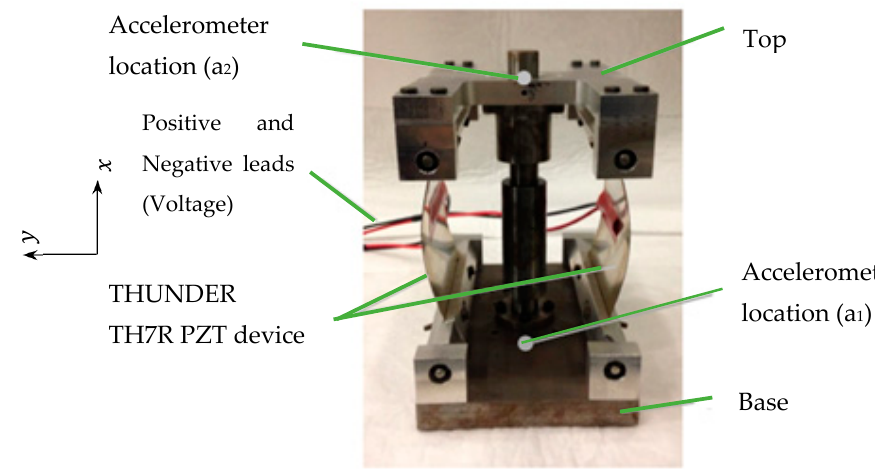
Figure 5. Photograph of the vibration energy harvesting device.